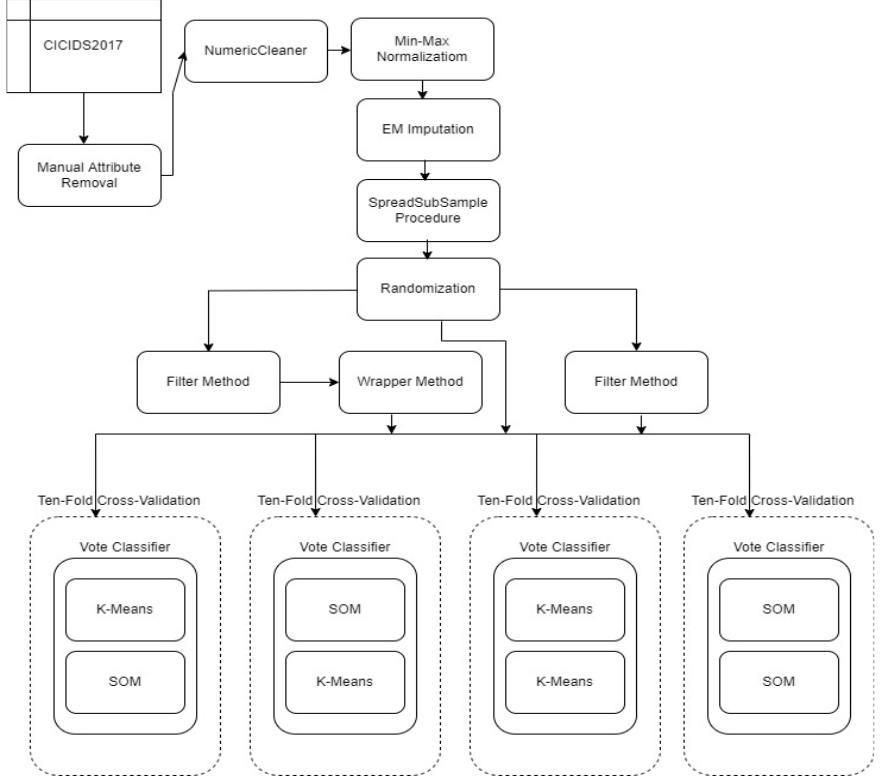
Figure 1. Evaluation approach of DDoS-attack detection methods.